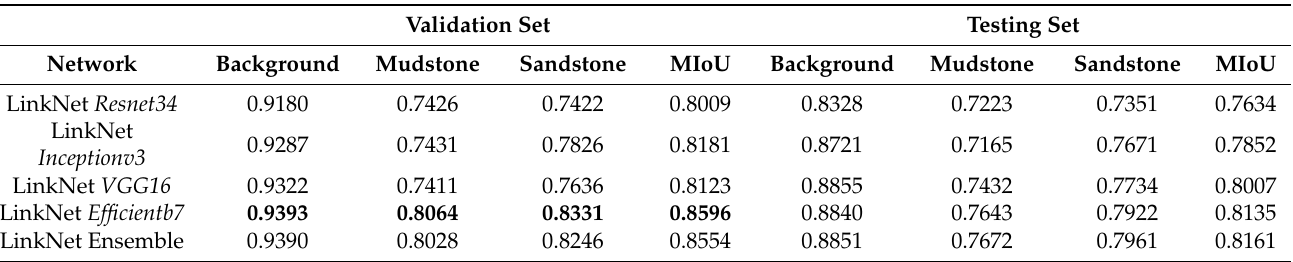
Table 3. Performance evaluation of LinkNet models for validation and test sets. The best test results are presented in bold.